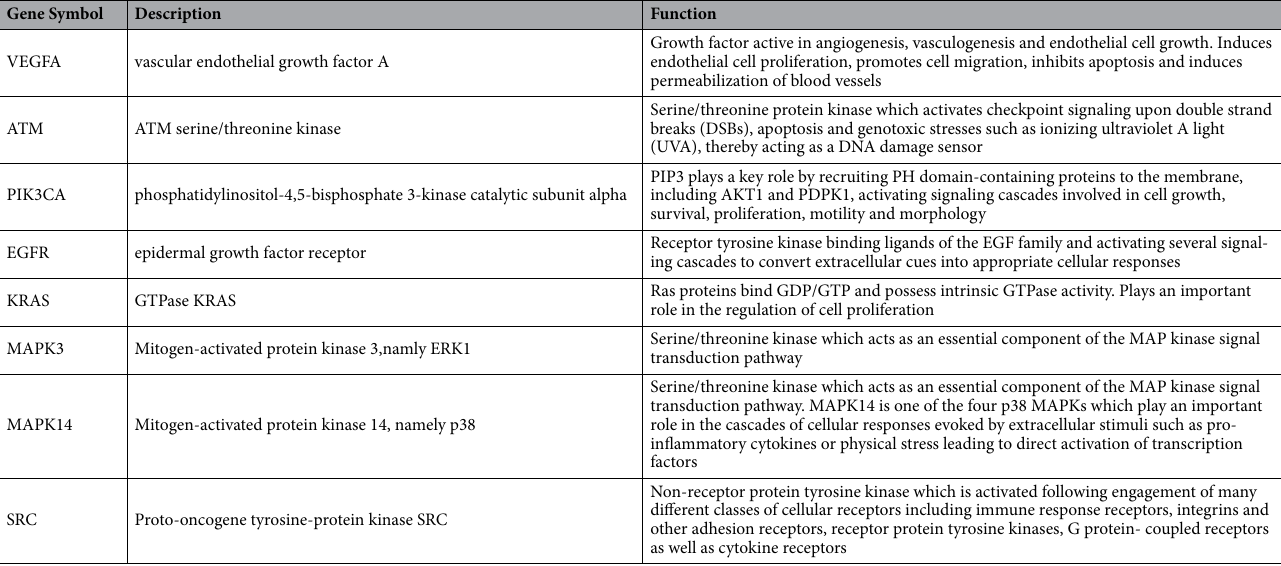
Table 2. The top 8 hub genes and their functions.